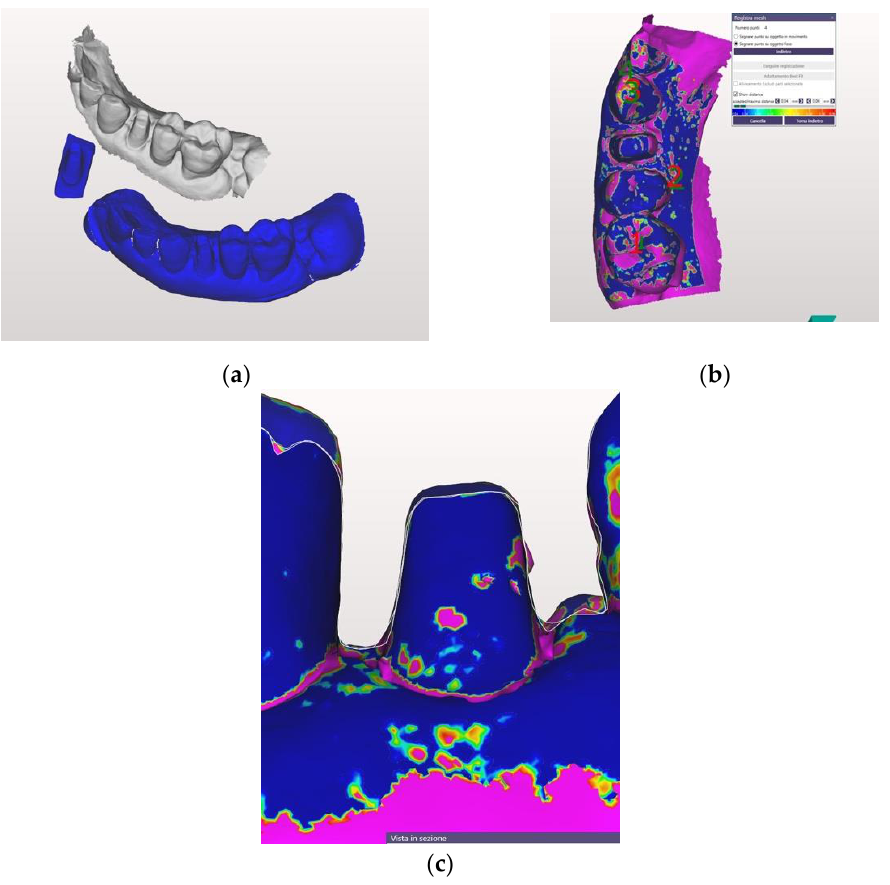
Figure 4. The two digital casts before being superimposed ( a ). The two digital casts after being superimposed ( b ). The abutment after being sovraimposed ( c )